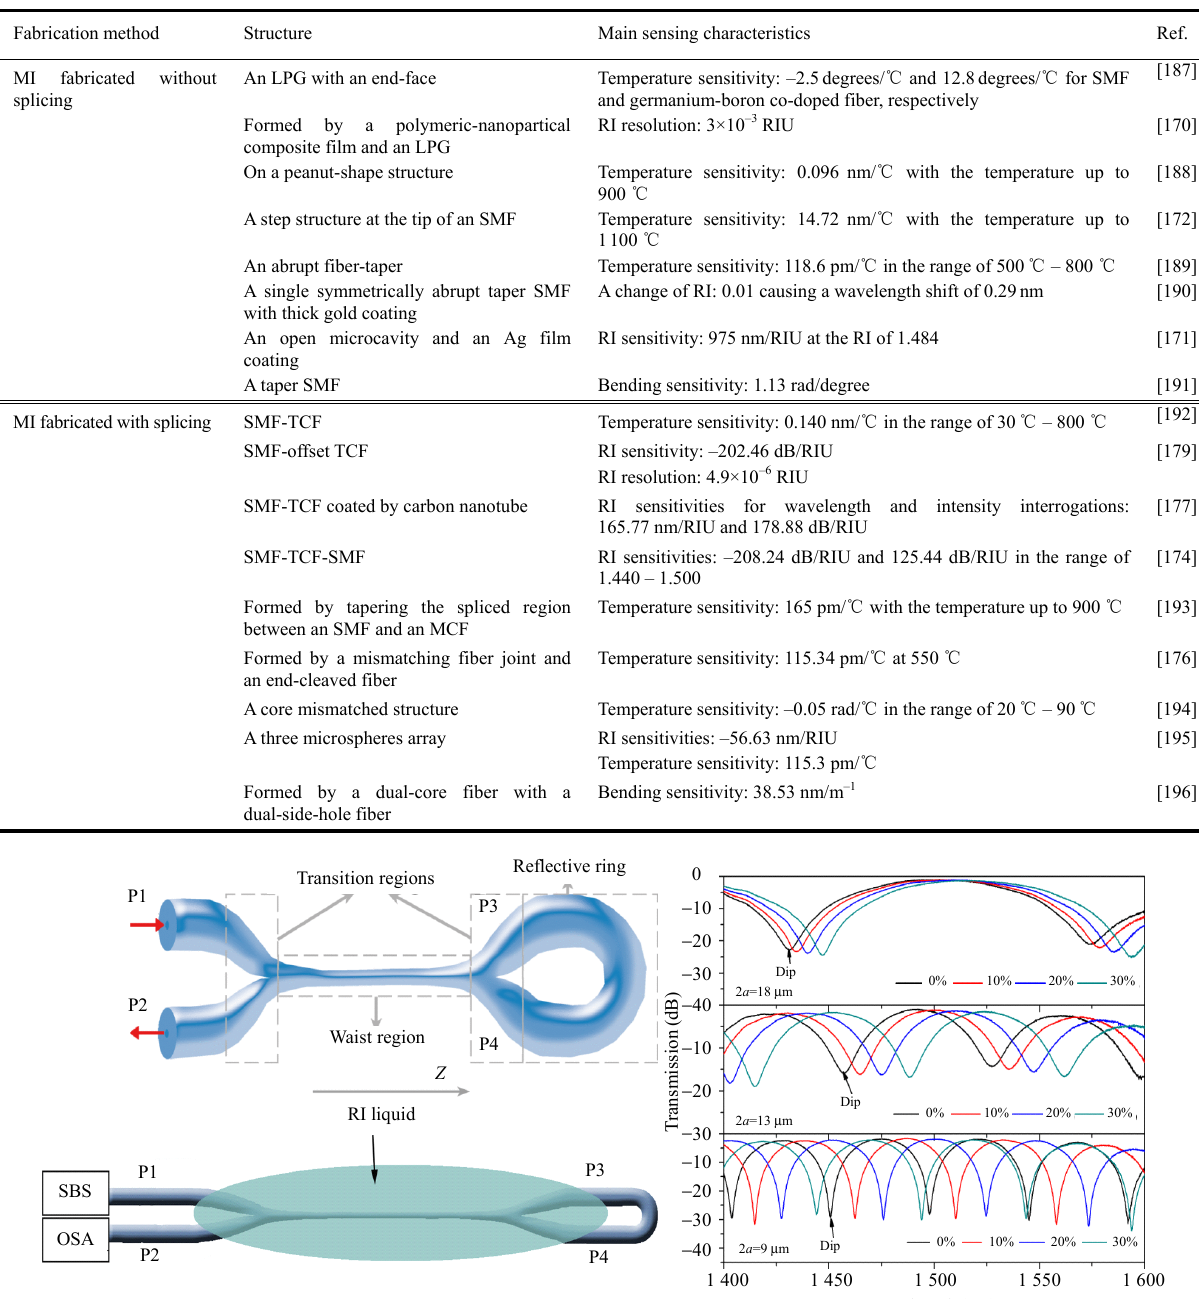
Table 7 Sensing characteristics comparison of different MI-based FOM sensors.